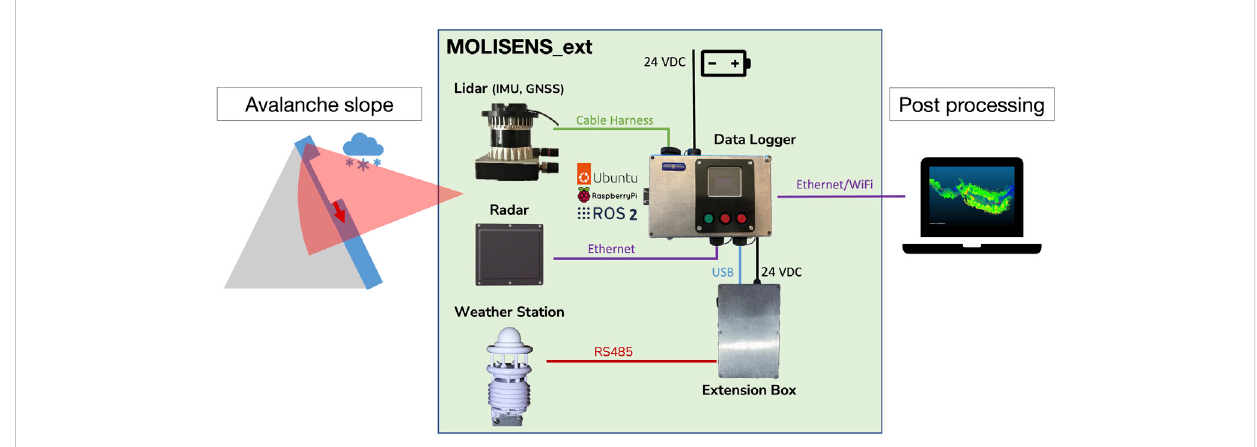
FIGURE 7 In this fi gure the hardware setup of the MOLISENS_ext system is shown. It is equipped with a GNSS receiver, an IMU, a lidar sensor, a radar sensor, and a weather station.